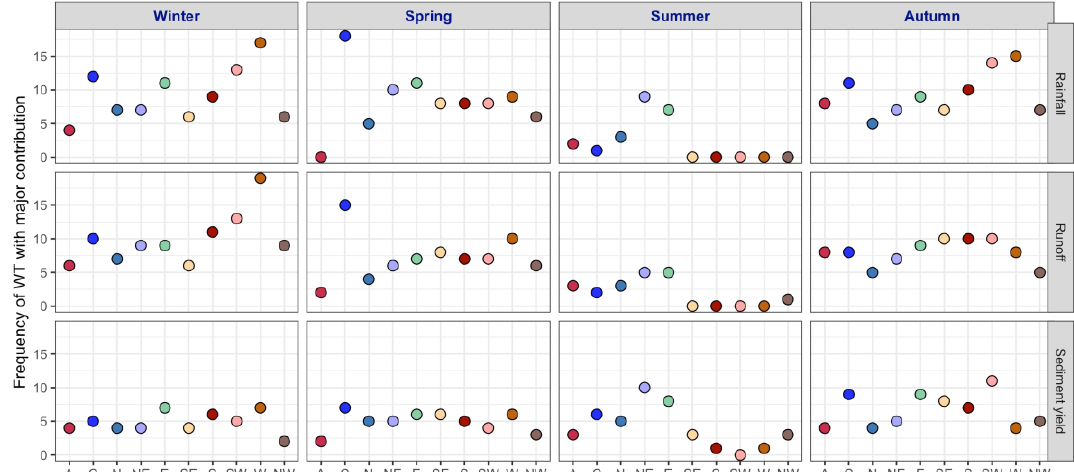
Figure 6. Frequency of the weather types with the major contribution (more than 5%) of the percentage of rainfall, runoff, and sediment yield in each season.